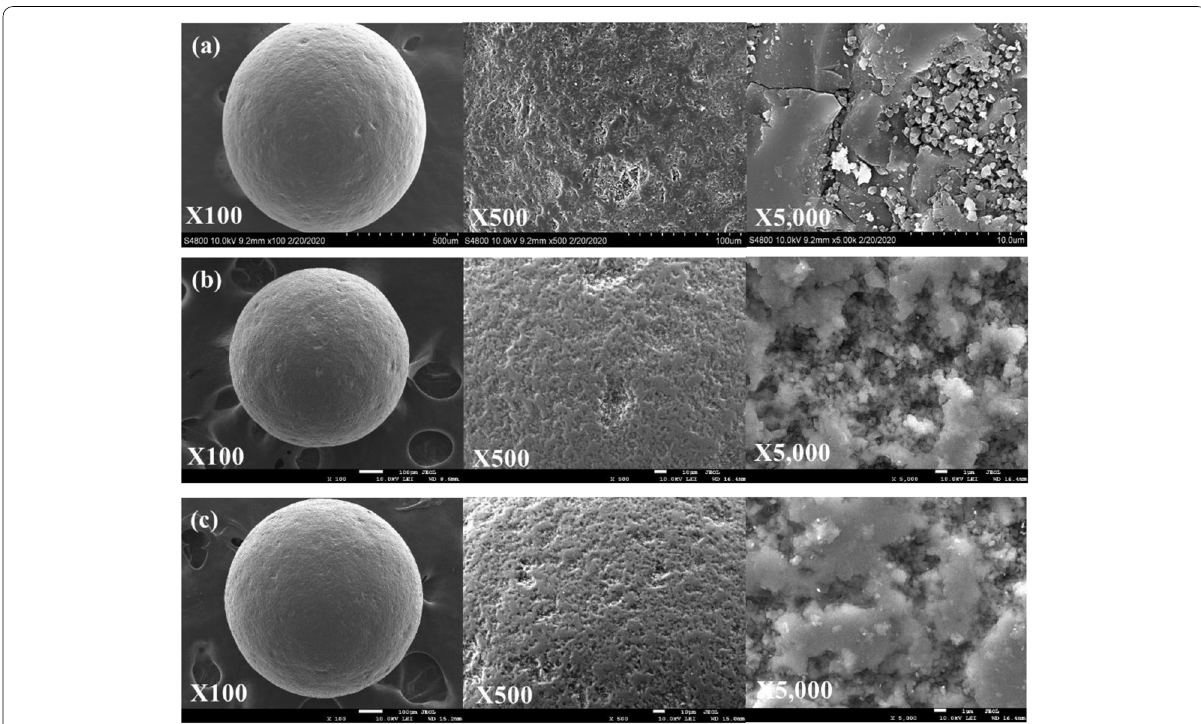
Fig. 5 SEM micrographs of a virgin KBAC, b TOL‑KBAC‑160 °C, and c MEK‑KBAC‑160 °C under resolutions of X100, X500, and